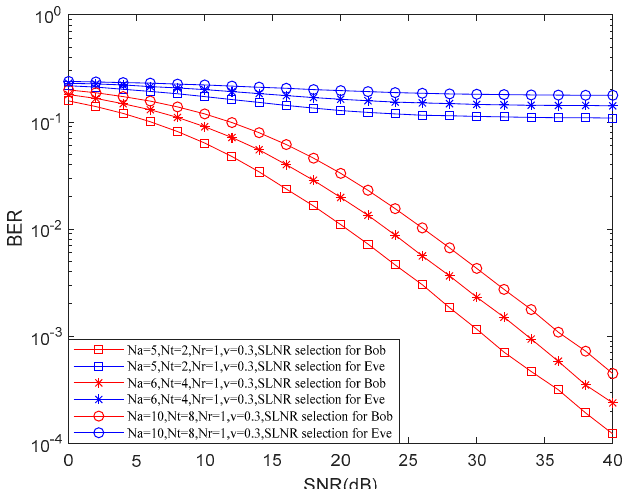
Figure 5. BER over SNR under different schemes for different 𝑣 .